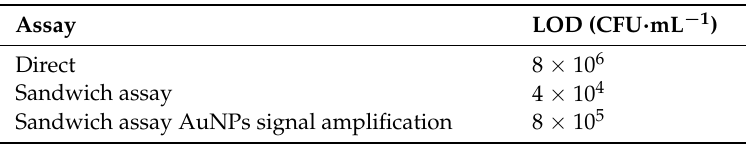
Table 1. Limit of detection (LOD) values for various assay formats.